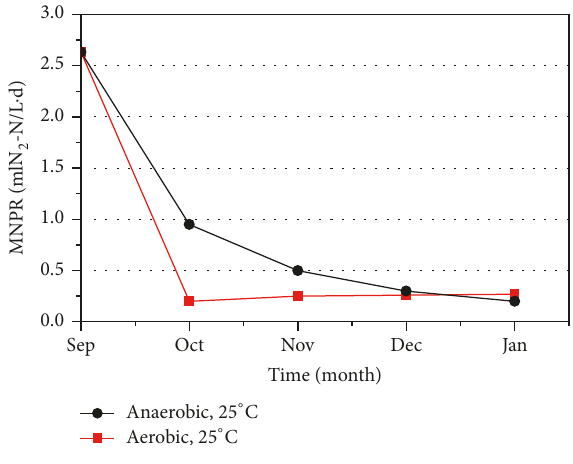
Figure 3: Variation of MNPR with time.